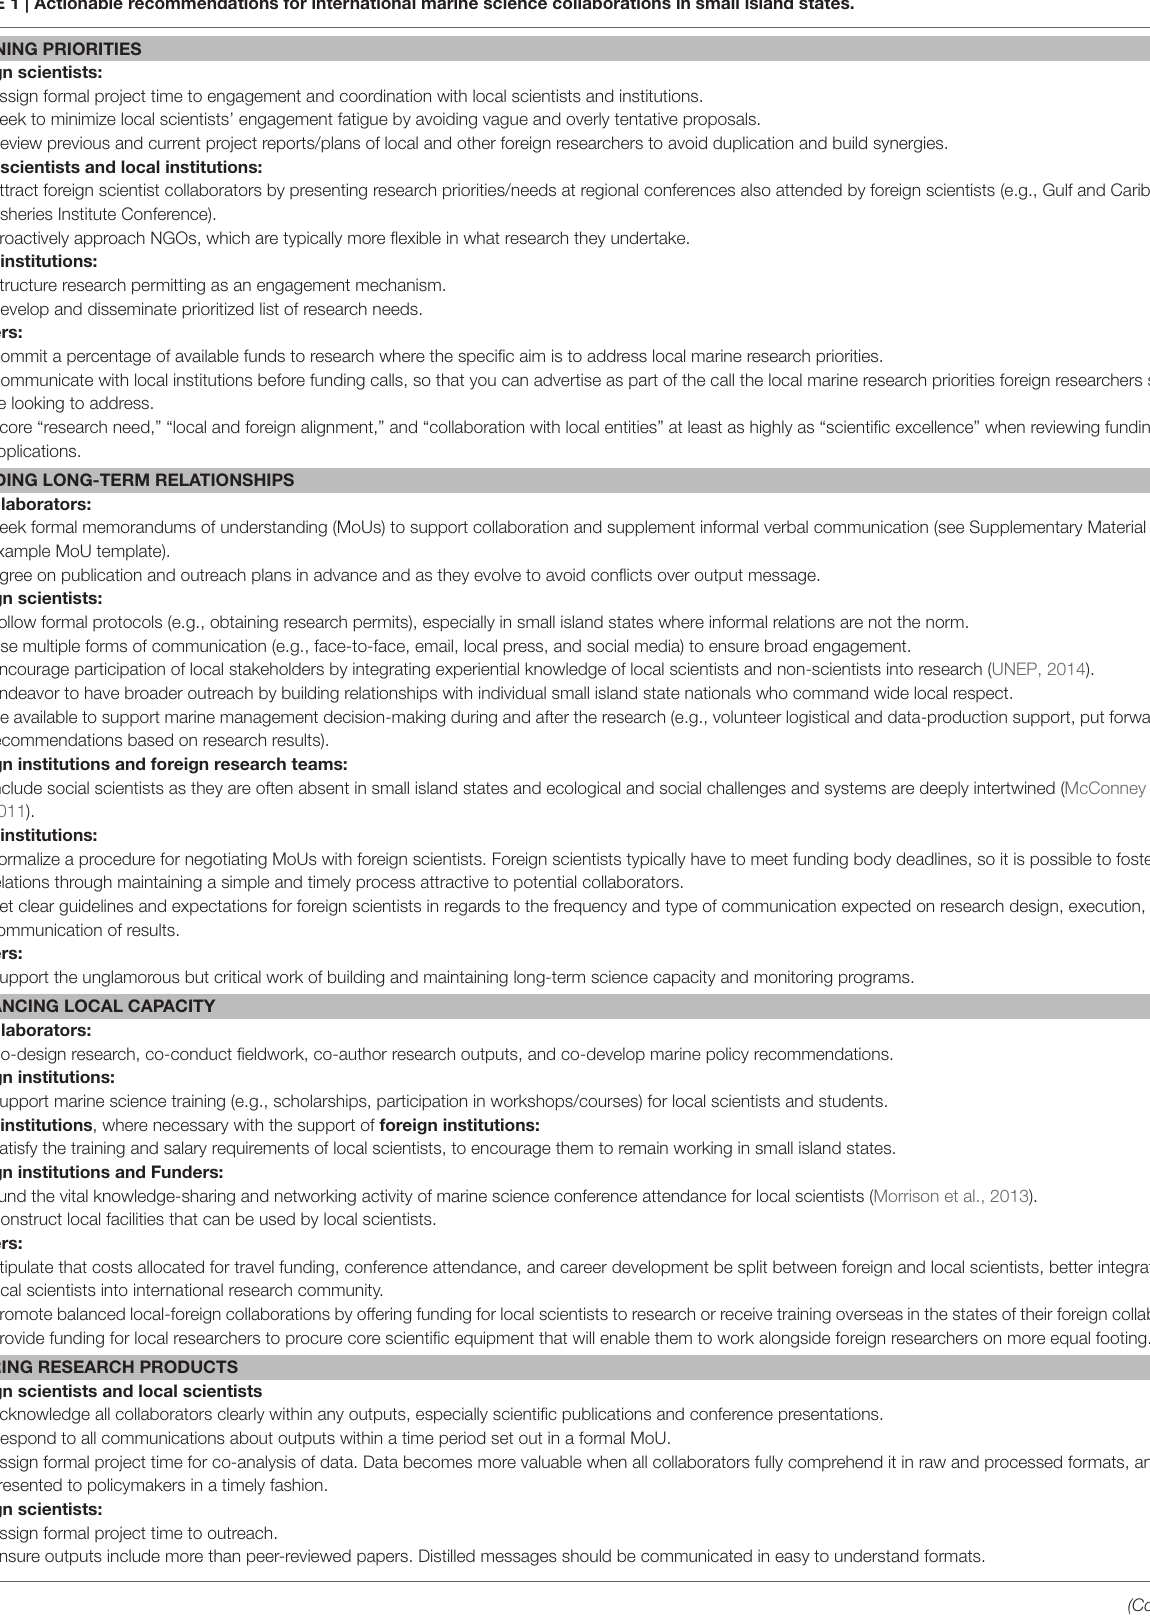
TABLE 1 | Actionable recommendations for international marine science collaborations in small island